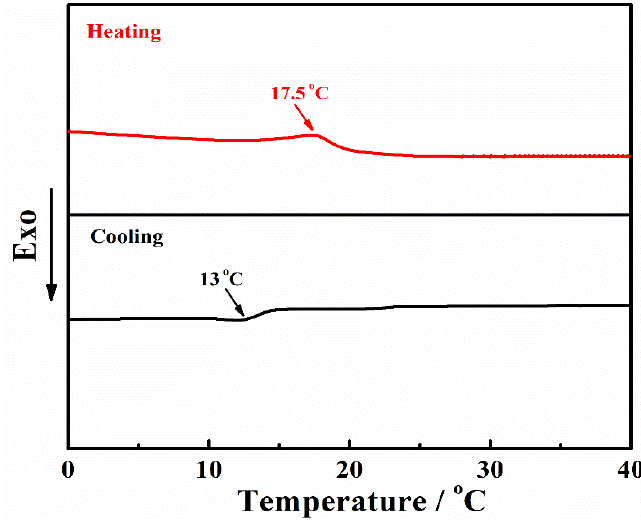
Figure 3. DSC spectra of liquid crystal/acrylate mixture system.